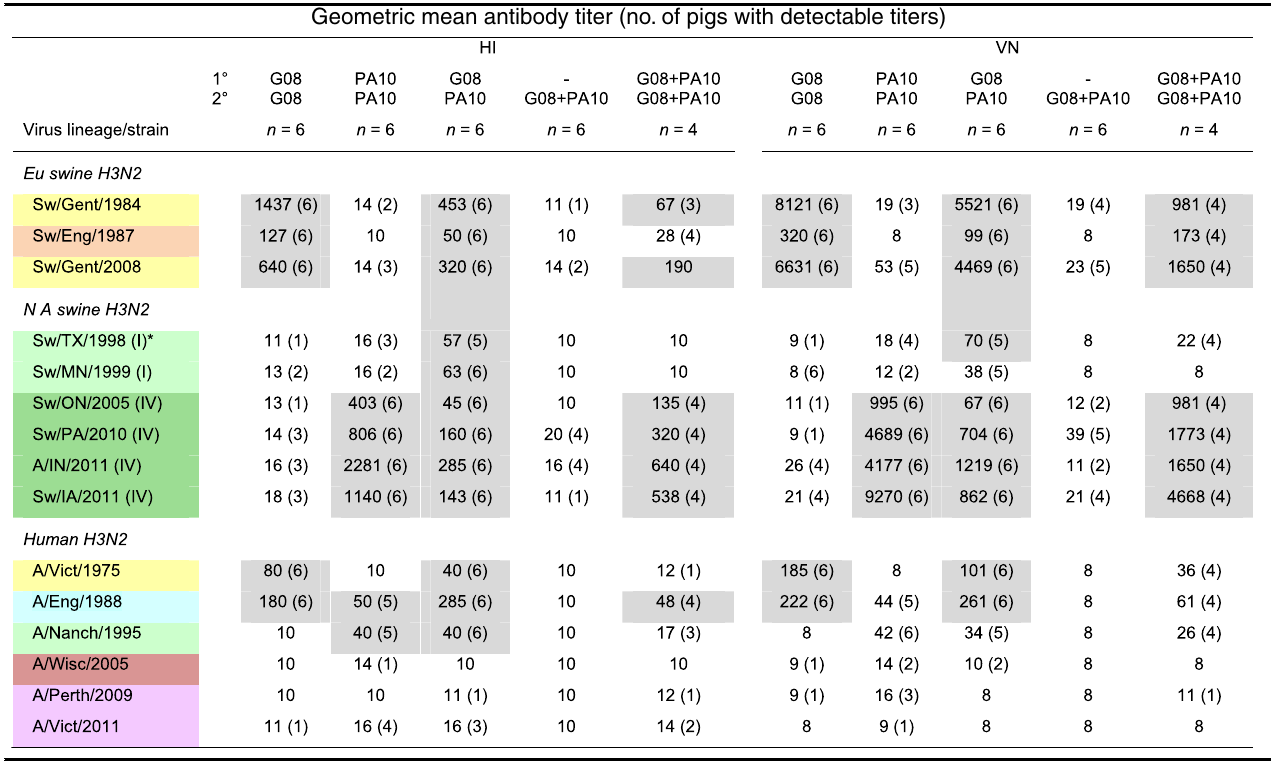
Table 2. Comparison of HI and VN antibody titers against heterologous H3N2 in fl uenza viruses in pigs of different vaccine groups Geometric mean antibody titer (no. of pigs with detectable